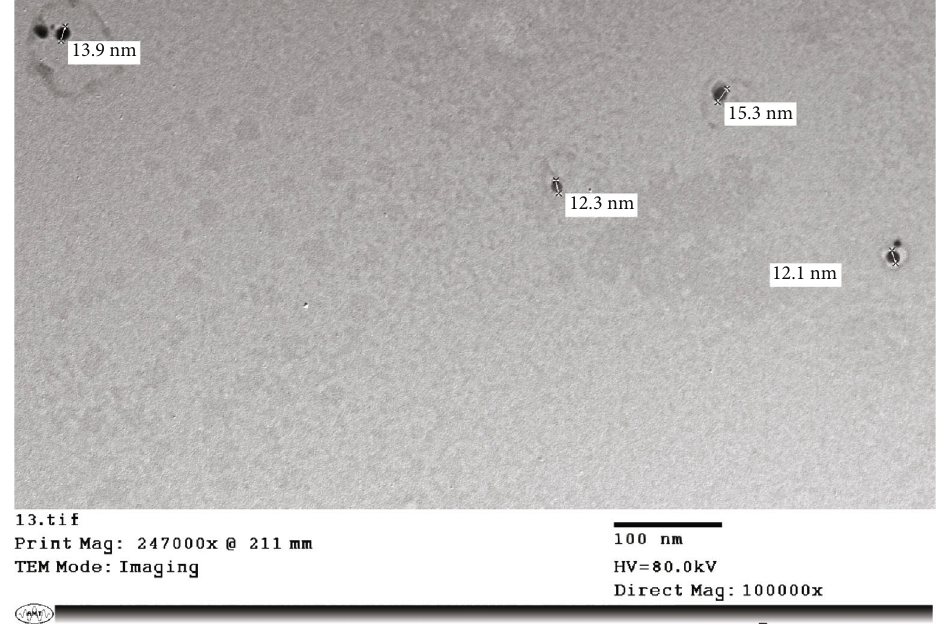
Figure 1: The AgNPs obtained from vanillic acid as seen by TEM. Particle size ranged from 12.1 to